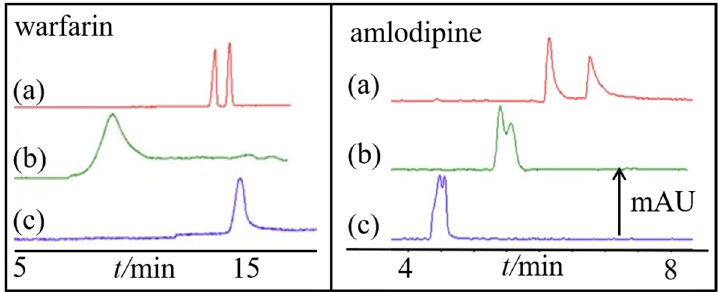
Figure 3. Electrochromatograms under different separation conditions ( a – c ). Conditions: fused-silica capillary, 33 cm (24.5 cm effective length) × 50 μ m i.d.; capillary temperature, 25 °C; sample injection: 5 s at 50 mbar; For warfarin, applied voltage: ( a ), ( b ) − 6 kV, ( c ) 6 kV; BGS: 20 mM phosphate buffered saline (PBS) containing ( a ) 2% SBE- β -CD ( w / v ) + 1.2% ( w / v ) liposomes, ( b ) 2% SBE- β -CD ( w / v ) + 20 mM SDS, ( c ) the single SBE- β -CD system, buffer pH: 8.4; For amlodipine: − 10 kV, BGS: 20 mM PBS containing: ( a ) 1.5% SBE- β -CD + 0.96% liposomes; ( b ) 1.5% SBE- β -CD + 16 mM SDS; ( c ) the single SBE-